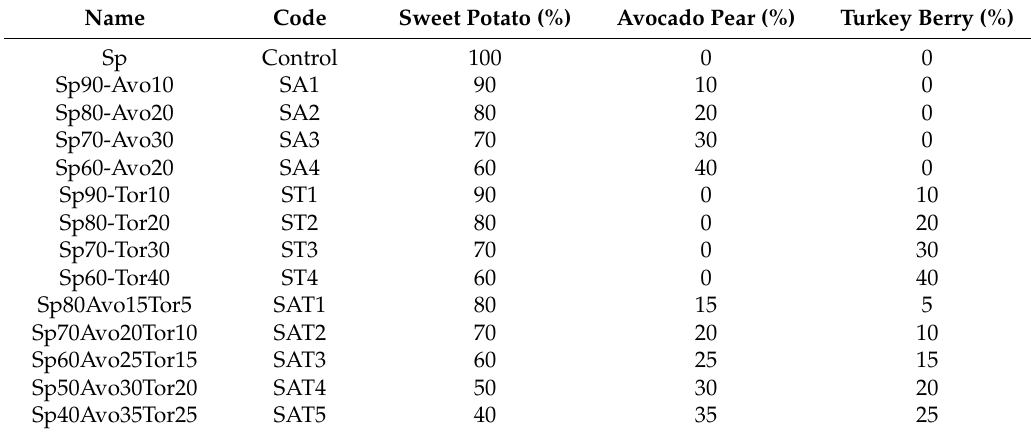
Table 1. Percentage (%) formulation of composite